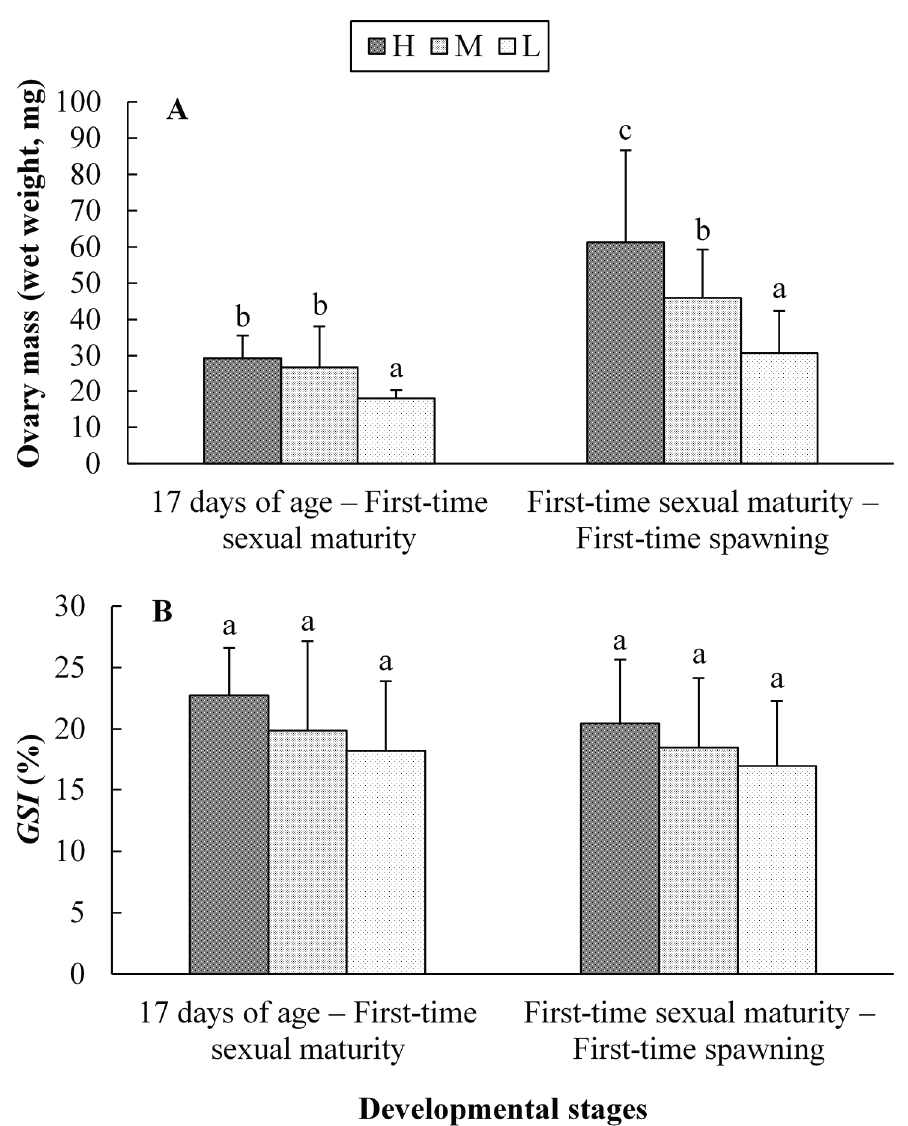
Figure 1. The ovary weight ( A ) and gonad-somatic index ( GSI ) ( B ) of female G. affinis at the first-time reproduction for three ration levels during different developmental stages